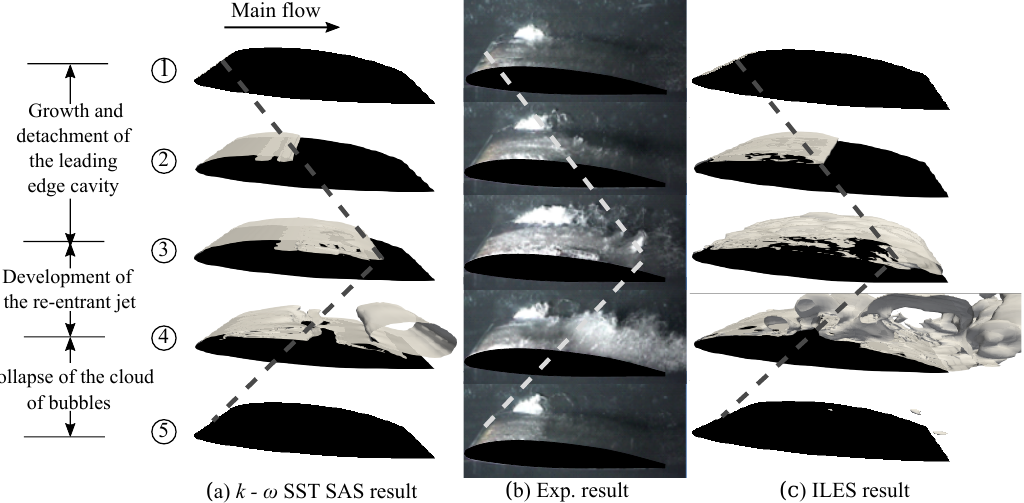
Figure 5. Typical cavitation cycle and comparison among results of NACA66 with iso–contour of α =